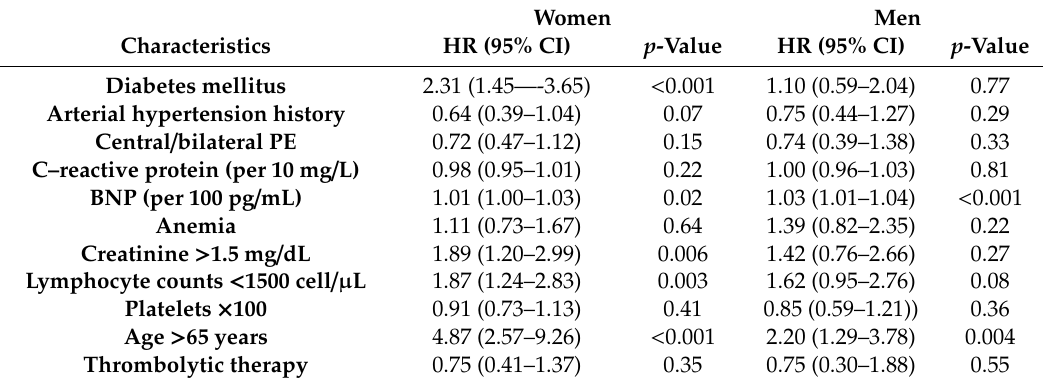
Figure 2. Kaplan–Meier survival curves according to the coexistence of DM separately in women ( left ) and men ( right ). Diabetes implies a survival disadvantage only in women. DM: diabetes mellitus. Table 3. Survival predictors in acute PE. Multivariate analysis stratified by gender. Women